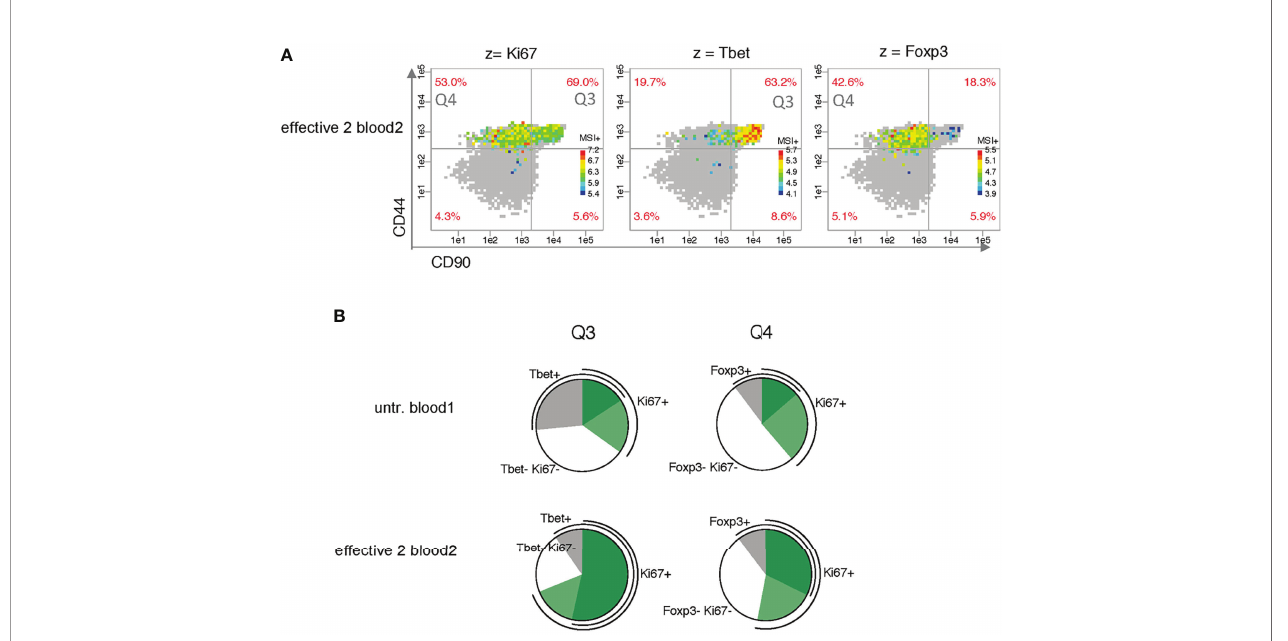
FIGURE 5 | Analysis of the co-expression of the proliferation marker Ki67 and the master transcription factors Tbet and Foxp3. (A) Analysis of bin patterns for mean signal intensity of z + cells (MSI + ) using one exemplary sample for effective therapy (effective 2 blood2) for Ki67, Tbet and Foxp3 using dynamic ranges for each sample. (B) Pie charts show differences in Ki67 co-expression between the two exemplary samples (untreated blood1 and effective 2